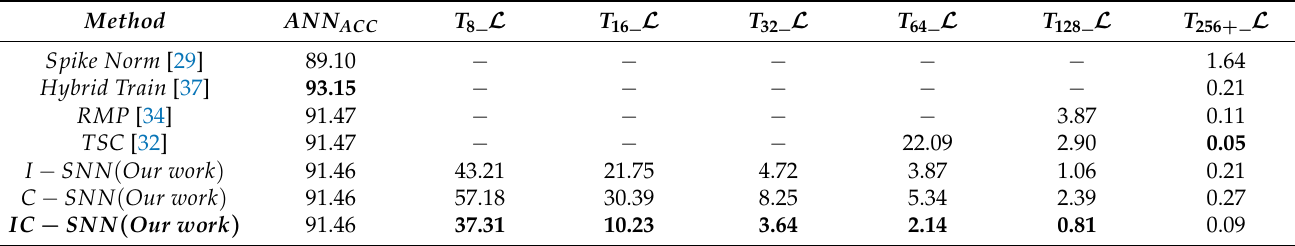
Table 4. Results of the test on the CIFAR10 dataset using